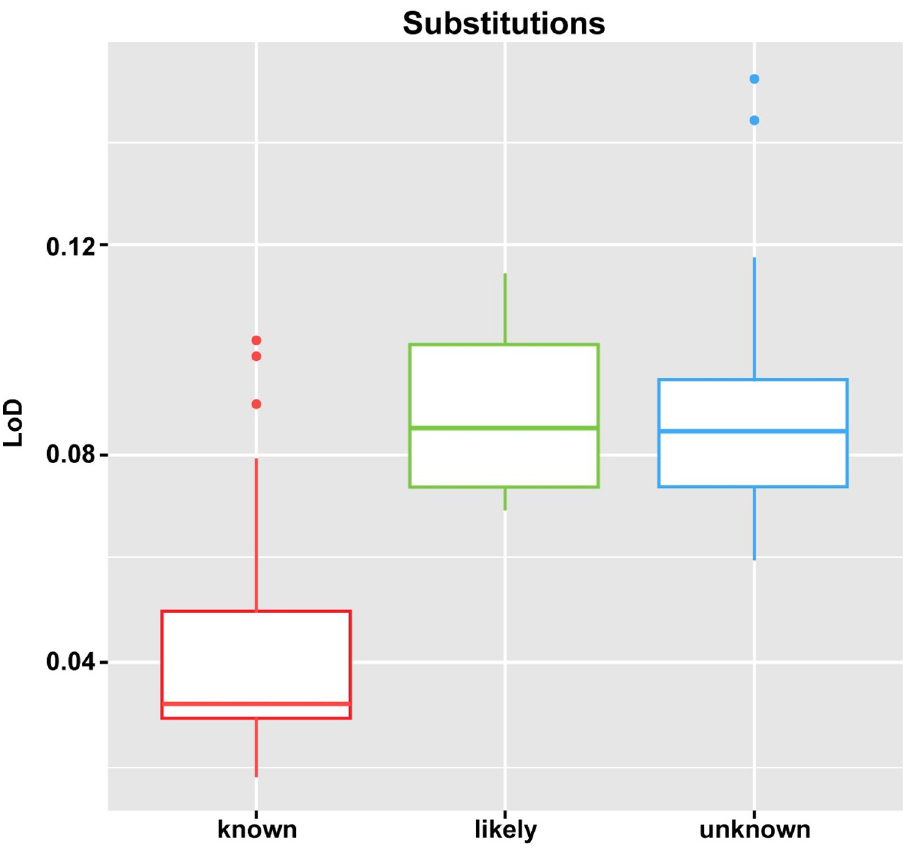
Table S36 in S1